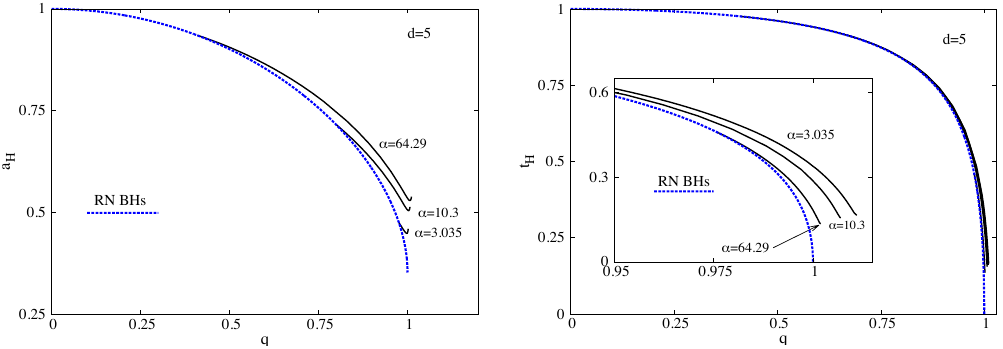
Figure 2 . Sequences of scalarized d = 5 RN BHs, with several values of (cid:11) , in a charge vs. horizon area (left panel) and a charge vs. Hawking temperature (right panel) diagram. The quantities are the reduced ones, i.e. given in units of